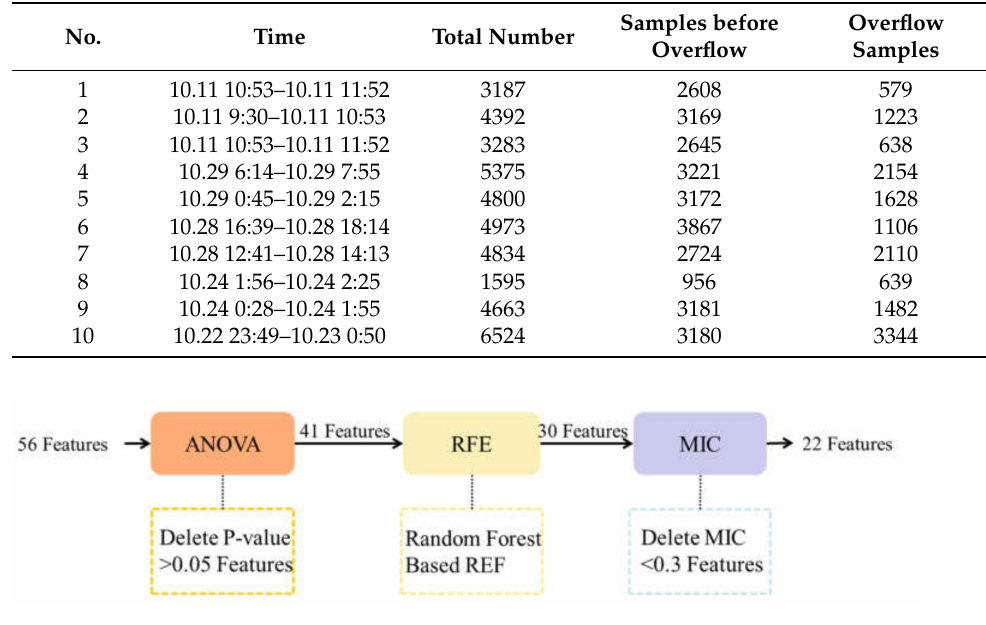
Figure 2. Flowchart of three-step feature selection. Table 2. Data feature table after feature